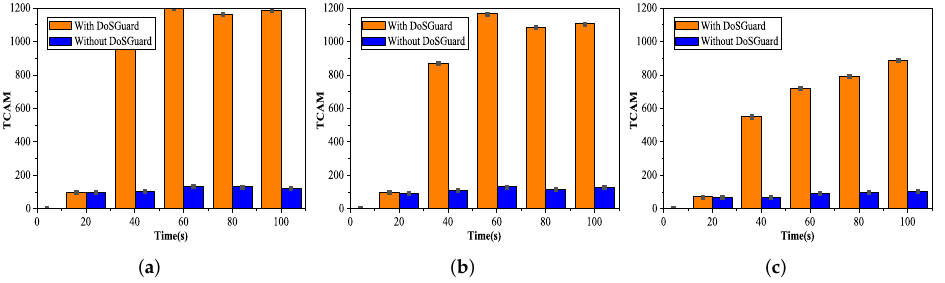
Figure 6. Defense effects on OpenFlow switch. ( a ) Fake source MAC address. ( b ) Fake source